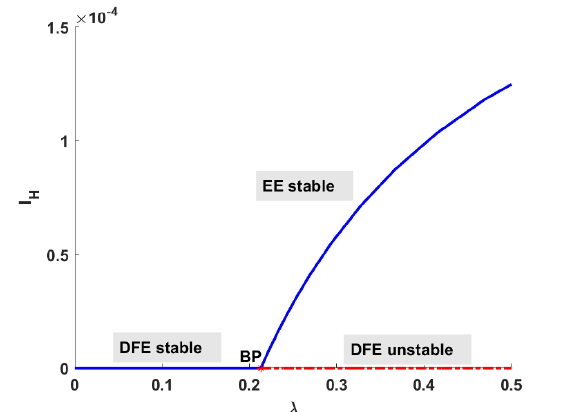
Fig. 4: Bifurcation figure when λ is taken as a bifurcation parameter of system (2) with a bifurcation value λ ∗ = 0 . 2132 at R 0 = 1 and by fixing parameter α 1 = 2 , α 2 = 3 , κ 1 = 0 . 3 , κ 2 = 0 . 2 , ε 1 = 0 . 67 , ε 2 = 0 . 06 , ε 3 = 0 . 06 , µ H = 0 . 00004 , µ V = 1 / 14 , µ U = 1 / 14 , β 1 = 0 . 15 , β 2 = 0 . 1 , γ = 0 . 16 , θ 1 = 0 . 33 , θ 2 = 0 . 3